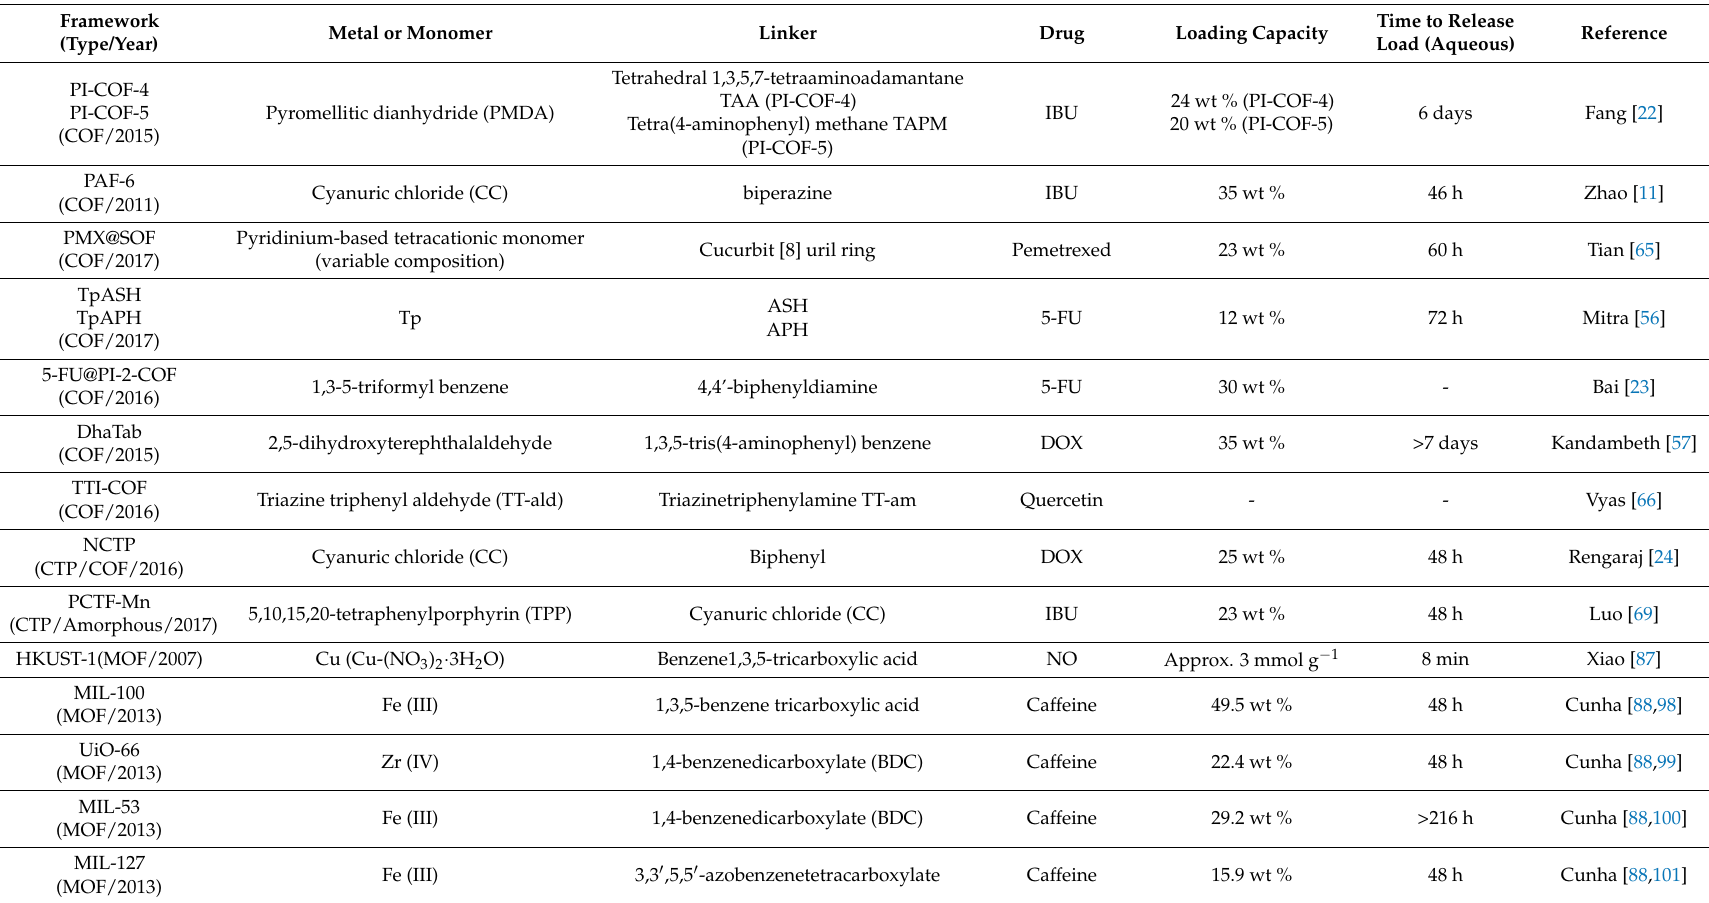
Table 1. Some reported COF and MOF Drug-Delivery